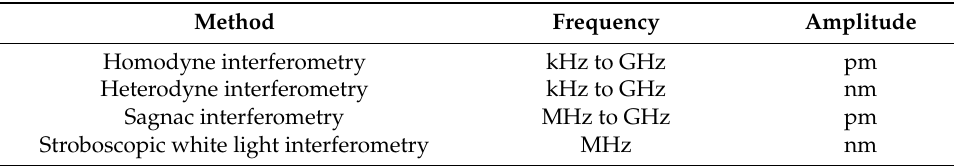
Table 1. The frequency and amplitude of the above methods. Method Frequency Amplitude Homodyne interferometry kHz to GHz pm Heterodyne interferometry kHz to GHz nm Sagnac interferometry MHz to GHz pm Stroboscopic white light interferometry MHz